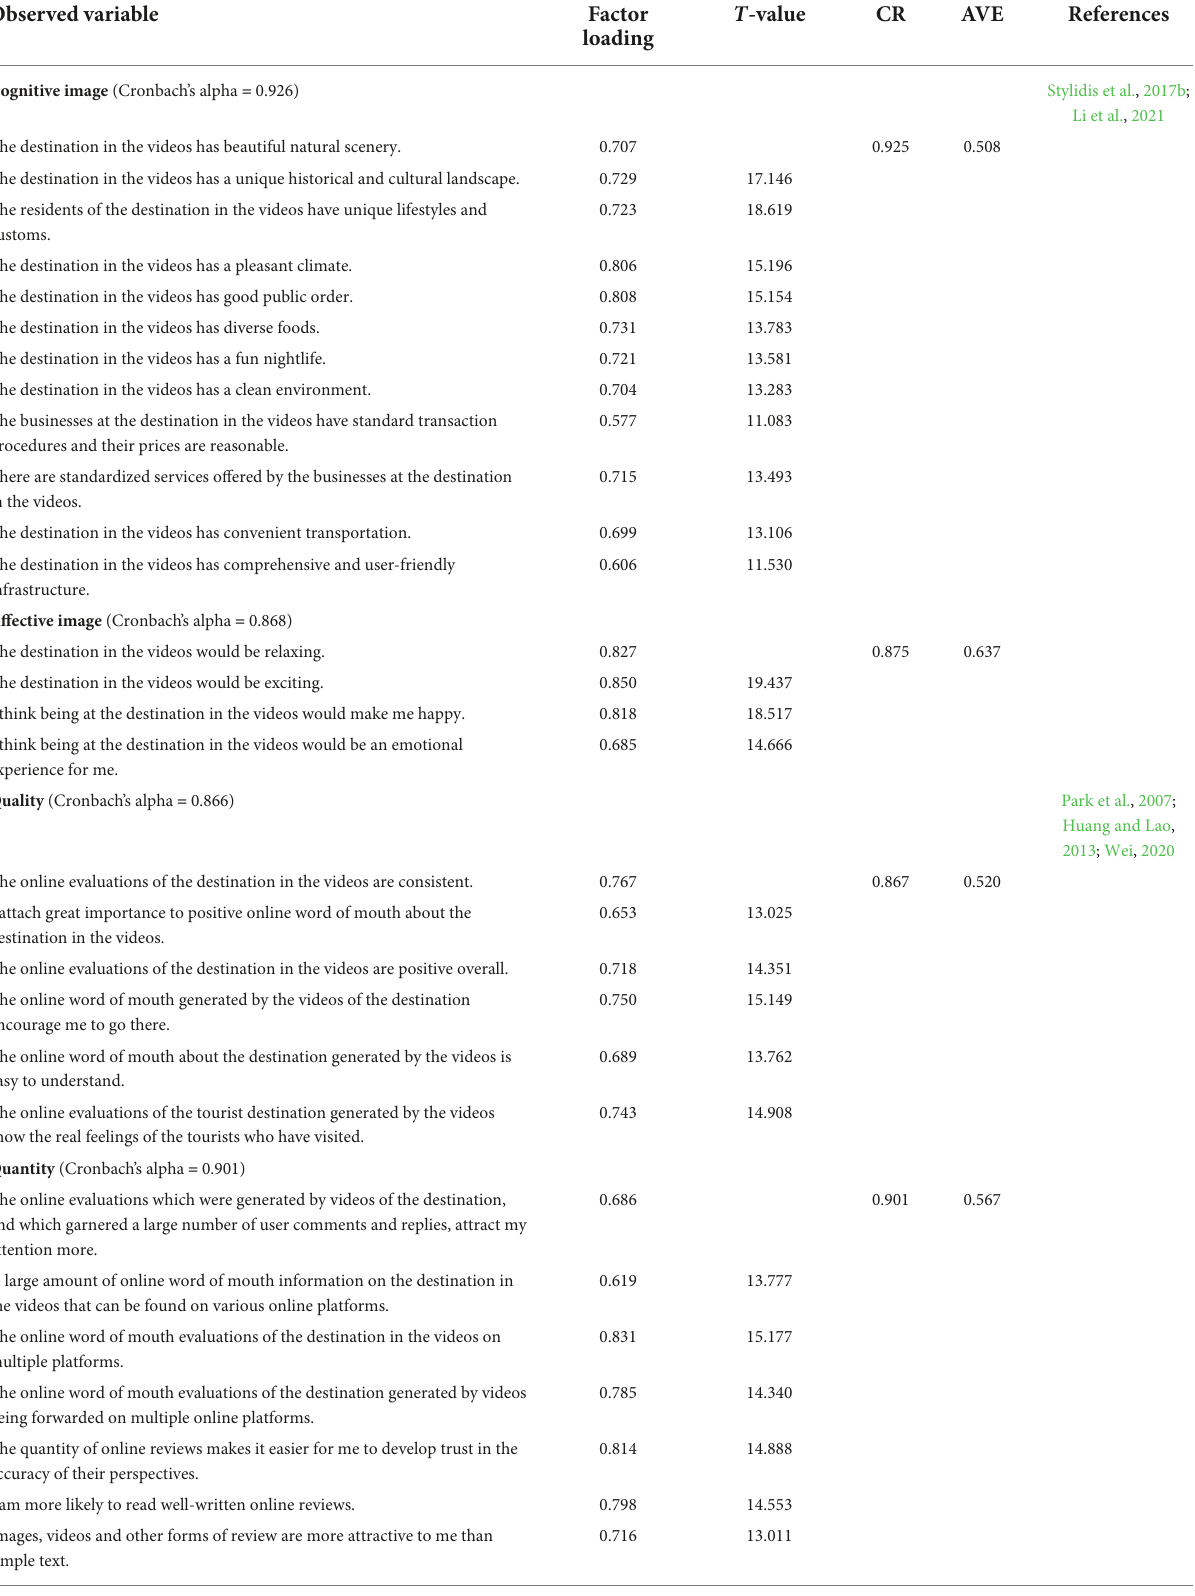
TABLE 2 Confirmatory factor